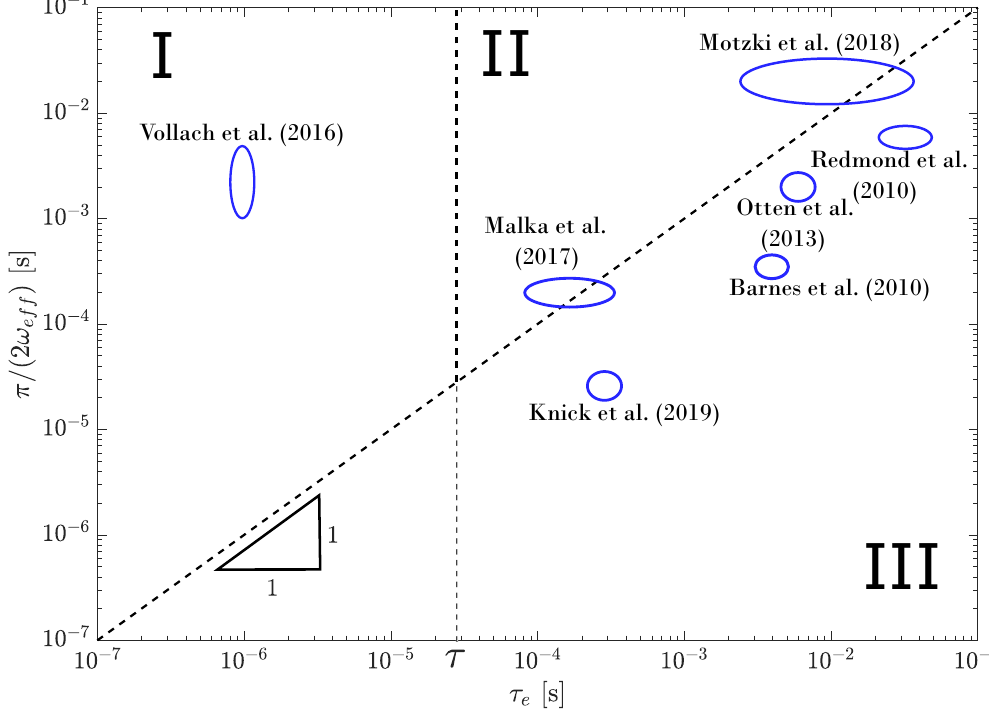
Figure 20. Comparison of previous experimental studies based on the different actuation regimes (see Figure